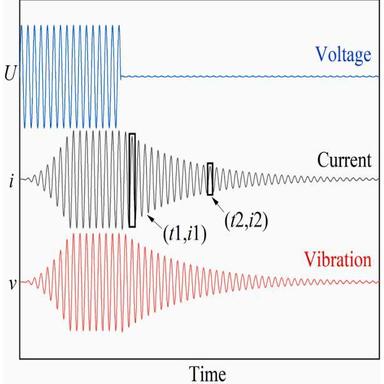
Transient characteristics of voltage, current, and vibration waveforms for a piezoelectric resonator under short-circuit condition.